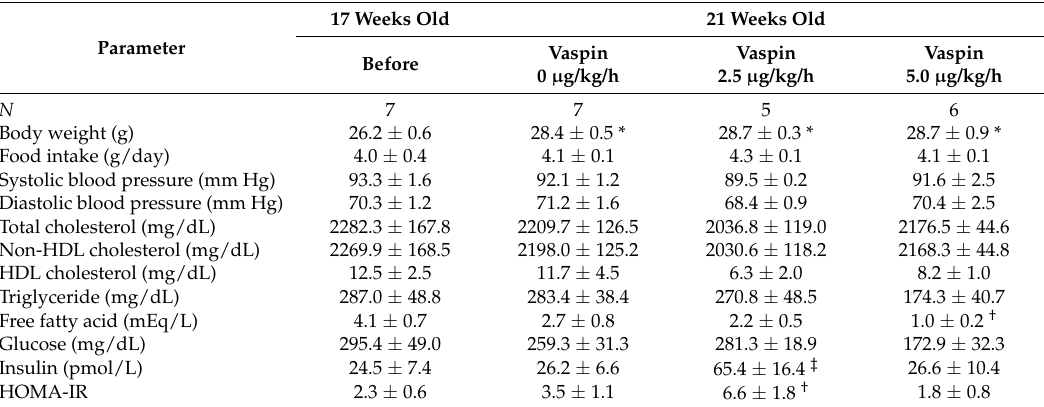
Table 1. Characteristics and laboratory data of Apoe − / − mice.